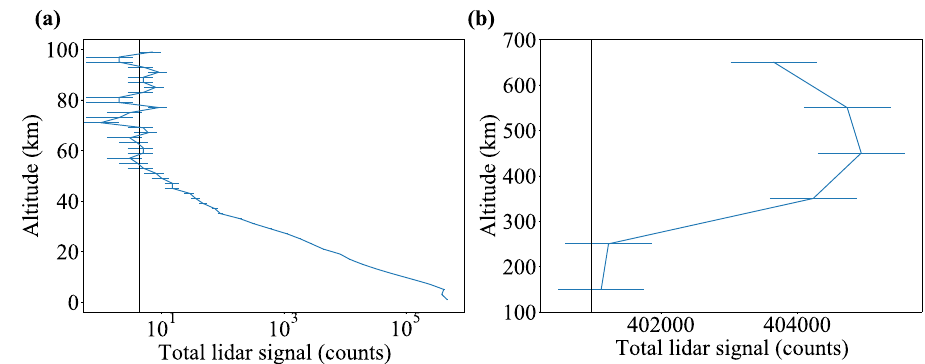
14, 2022. This return count pro fi le corresponds to the He(2 3 S) density pro fi le plotted in blue in Fig. 2b and comprises 5.7h of data. The vertical black line shows the background estimate for these data. The error bars represent 1 σ uncertainties arising from photon